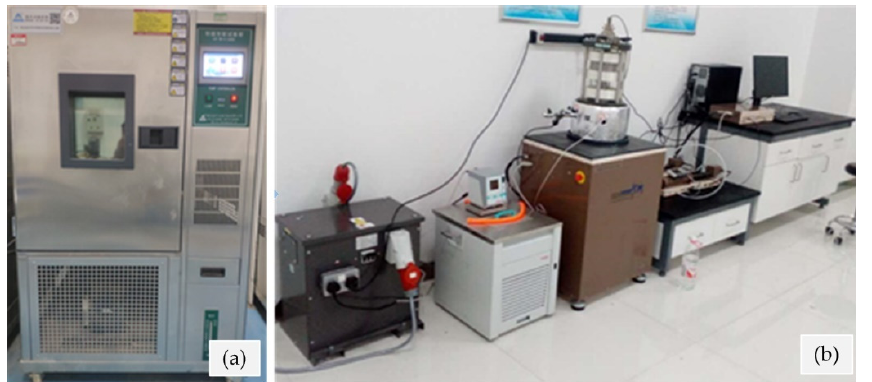
Figure 2. Test equipment: ( a ) Programmable temperature-controlled chamber; ( b ) GDS dynamic triaxial test system (GDS DYNTTS).